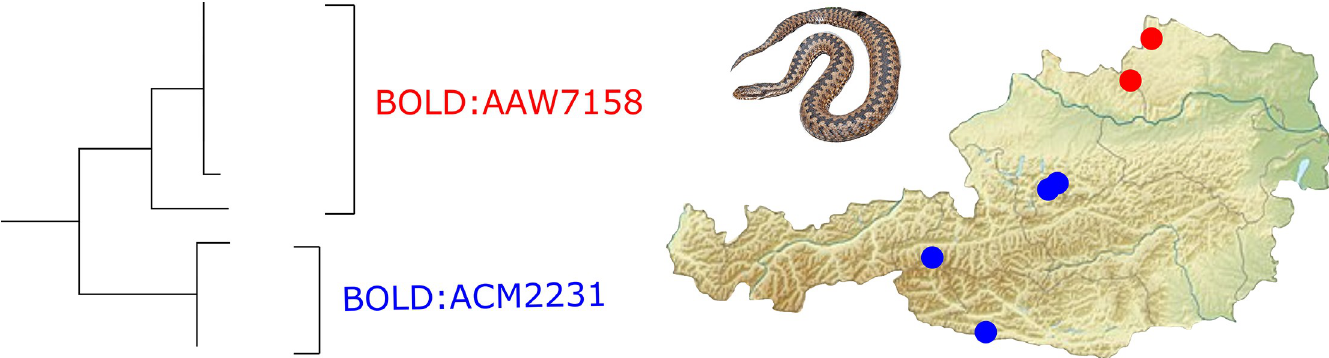
Fig 4. Subtree of the common European adder. COI sequences of V . berus allow for an assignment of origin from an inner alpine (blue) or adjacent lowland regions (red). Clades also include sequences from [7], only Austrian samples are displayed on the map.